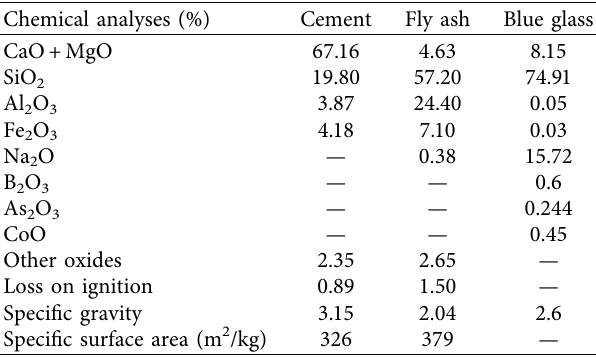
Table 1: Characteristics of cement, blue glass, and fy ash. Chemical analyses (%) Cement Fly